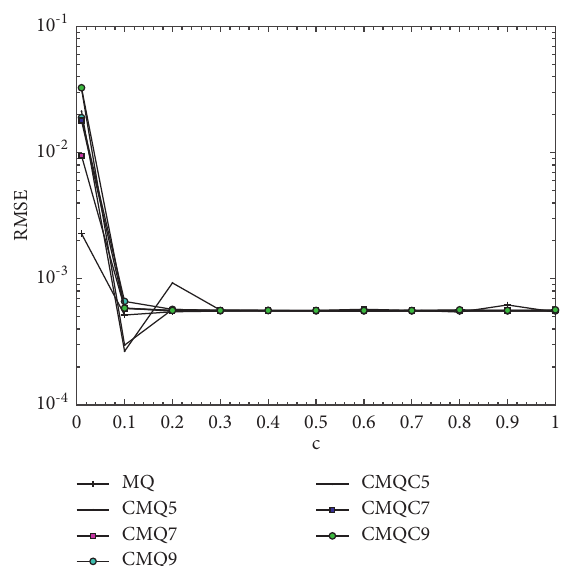
Figure 5: RMSEs for field solution versus the value of parameter c .